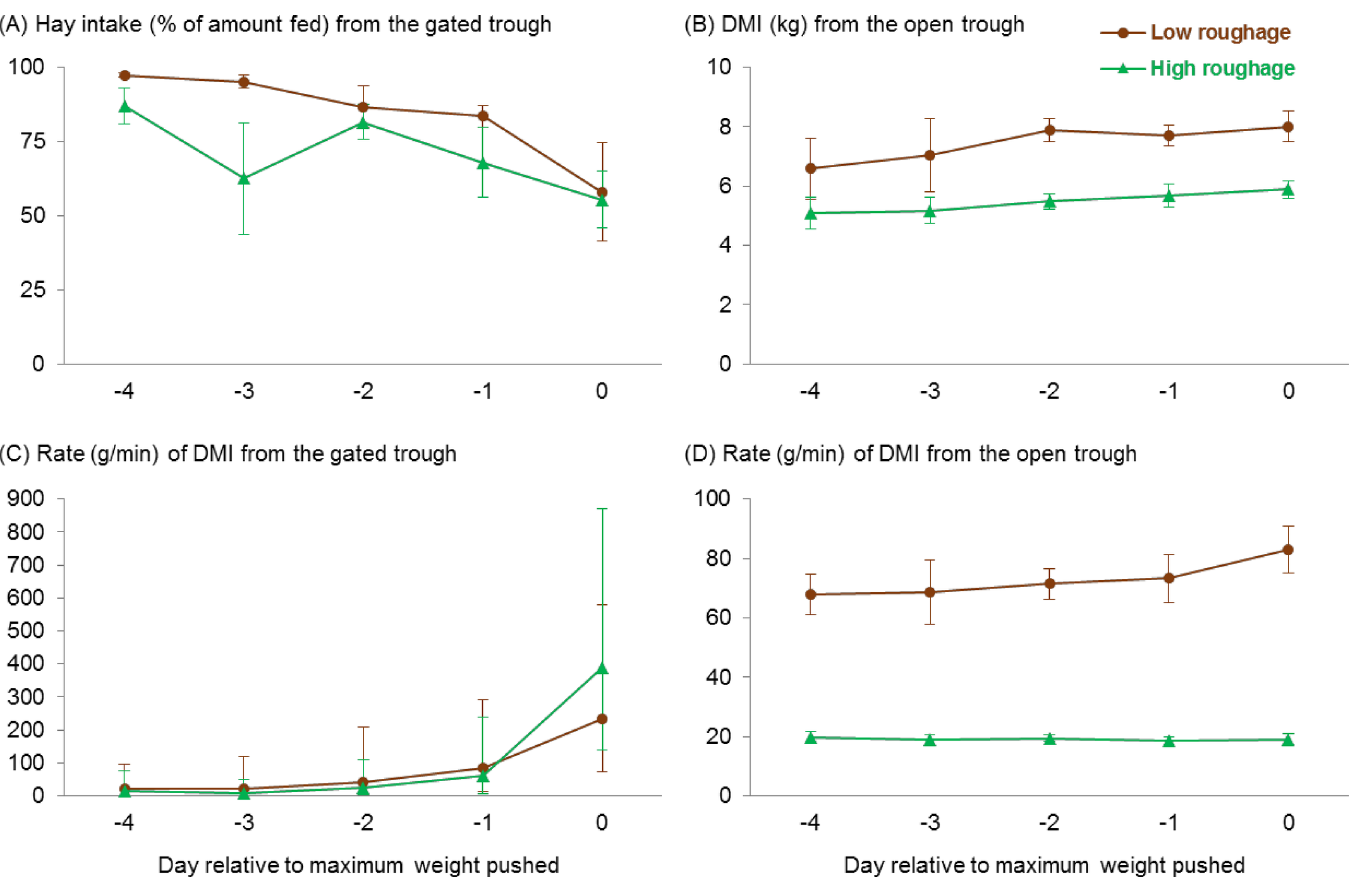
Fig 4. Feed intake and feeding rate from each trough. Means ± SEM are shown for intake of (A) Sudan grass hay from the gated trough and (B) the primary diet treatments from the open trough, (C) back-transformed means and 95% confidence intervals for the feeding rate from the gated trough, and (D) means ± SEM for the feeding rate from the open trough. All heifers were fed 200 g/d of Sudan grass hay behind a gate that must be pushed to gain access, and to which additional weight was added daily until cattle no longer used it. In the unrestricted open trough, heifers had free access to either a total mixed ration with 12% forage (as fed, low roughage, n = 6) or 100% Sudan grass hay (high roughage, n = 6). To allow for consistent comparisons among heifers, behavior was evaluated on 5 d (relative to the day they pushed the maximum weight), and data are presented across days. Day was included in the model as a continuous variable but was summarized as categorical for graphing purposes.